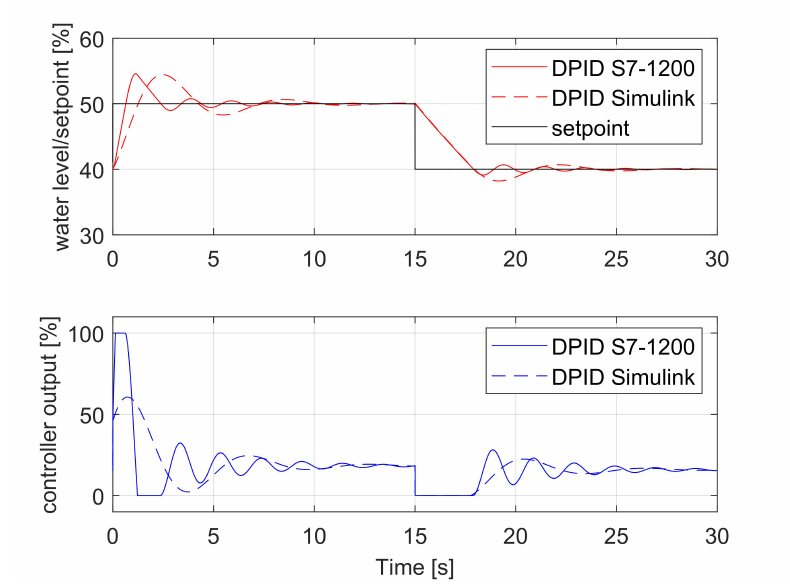
Figure 4. Discrete PID (DPID) closed-loop realizations’